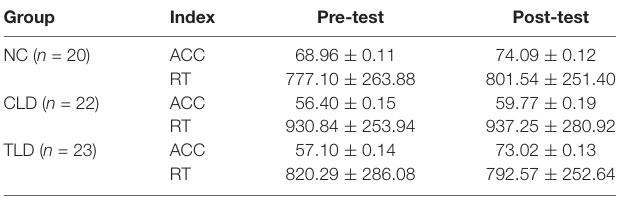
TABLE 1 | The ACC (%) and reaction time (RT) (ms) of 2-back task of each group in pre- and post-test training (M ± SD).